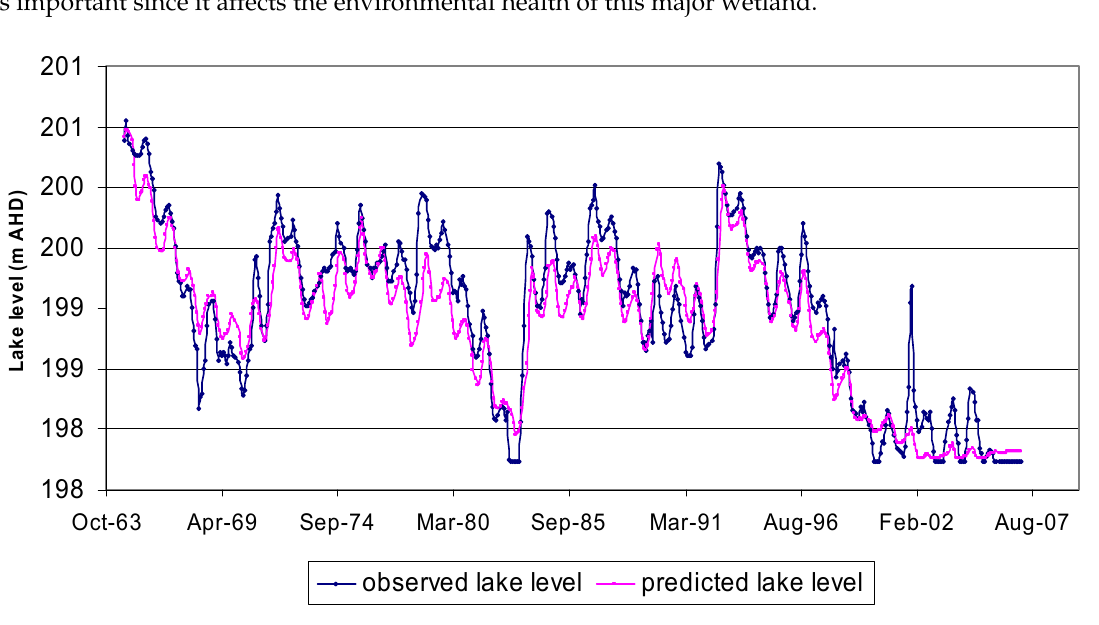
Figure 12. Correlation between observed and calculated lake elevation in AHD m. Table 1. Average long ‐ term (1964–2007) monthly contribution (in percent) of each Lake Linlithgow water budget component to the overall lake water budget. Evaporation (%)